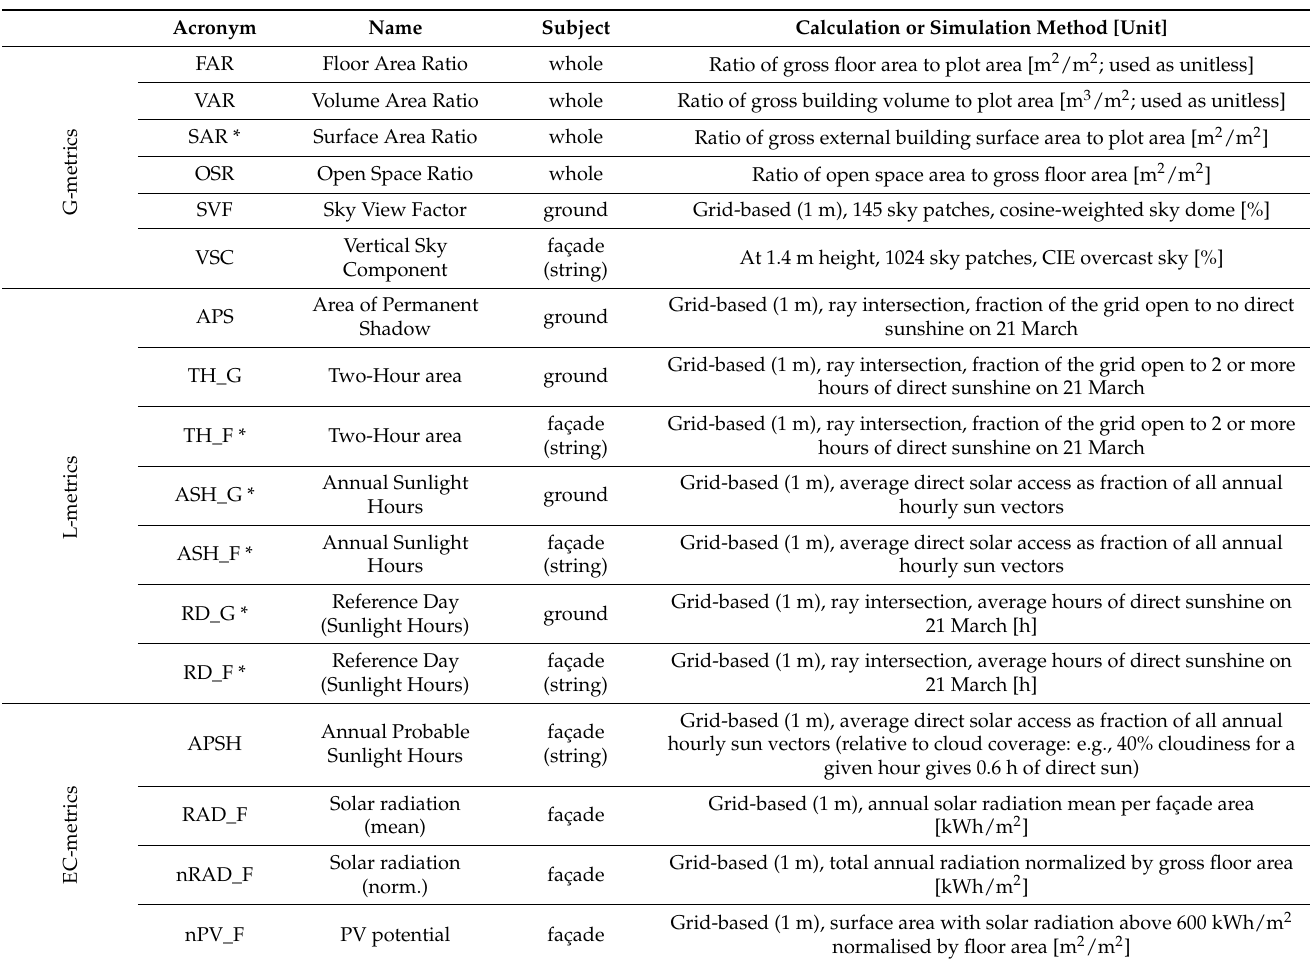
Figure 8. Two kinds of simulation point grids for façade-based metrics. Left : single string of points at 1.4 m height. Right : the whole façade made into a point grid. Table 2. List of metrics selected for analysis. Metrics that were not sourced from literature were marked with an